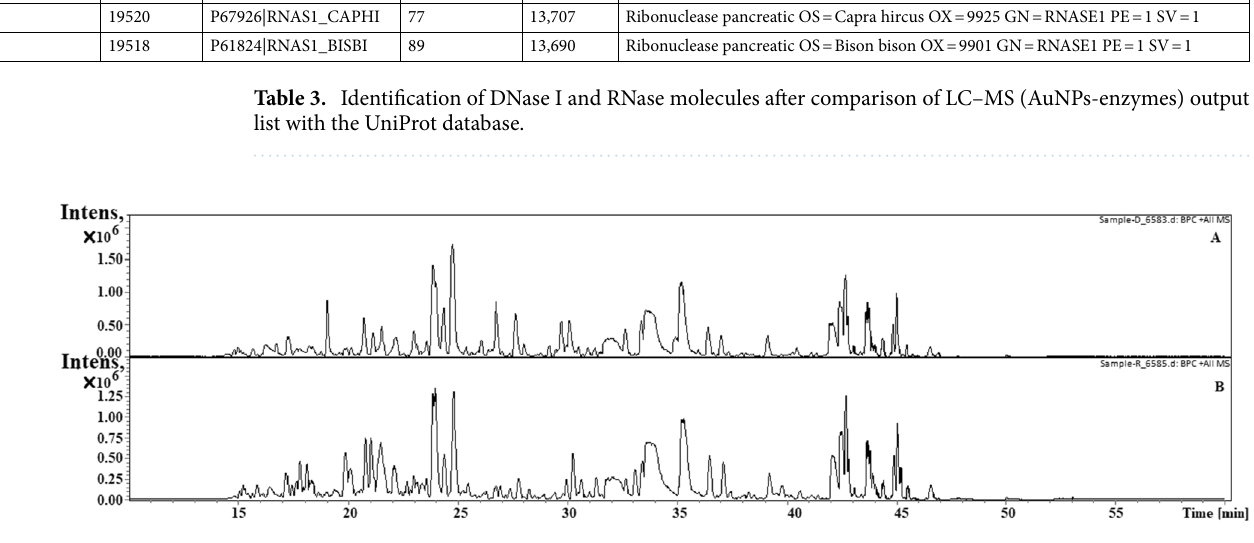
Figure 7. Representative LC–MS chromatogram of AuNPs-DNase I (top) and AuNPs-RNase A (bottom) that served for data mining and detection of the components of AuNP-enzyme complexes presented in Table